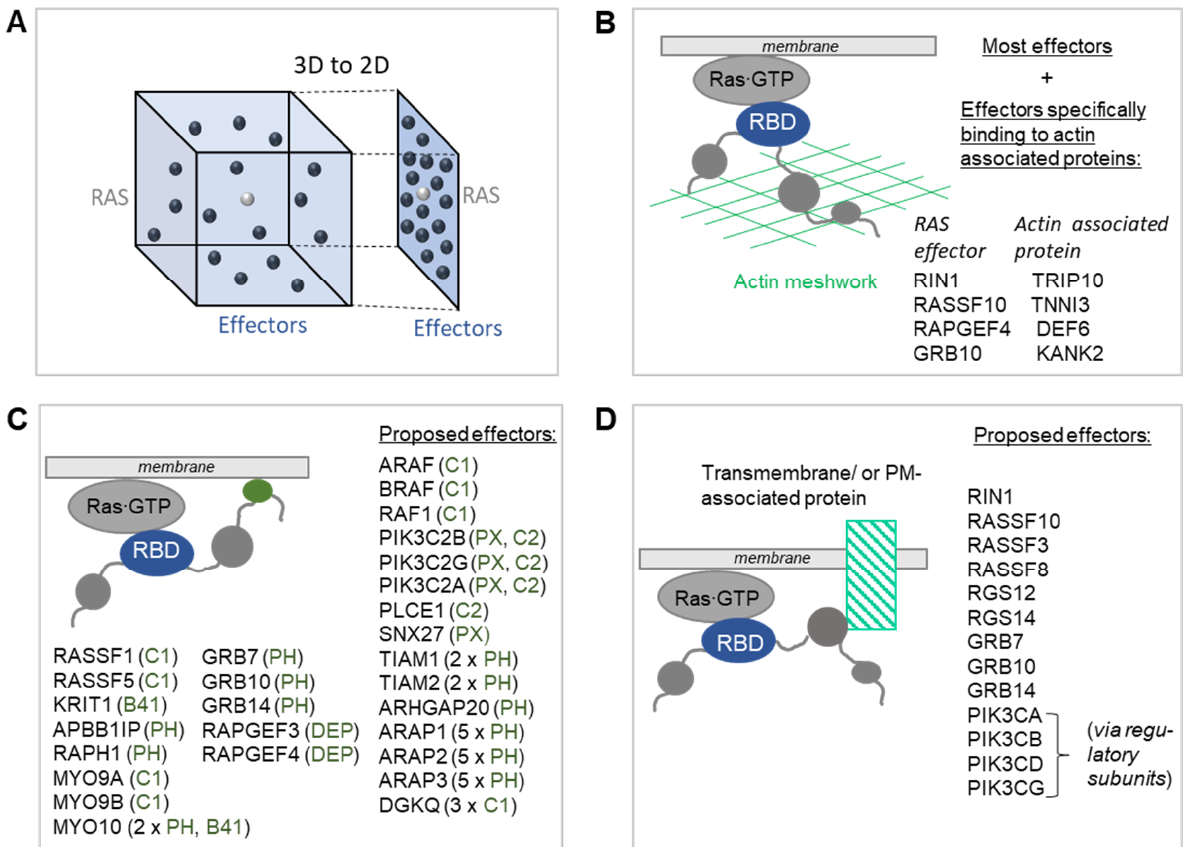
Figure 3. Mechanisms enhancing RAS effector recruitment. ( A ) The reduction of a three-dimensional space to the two- dimensions of a membrane can enhance the affinity between RAS and its effectors by >100 fold [29]. ( B ) Schematic representation of the recruitment of effectors to RAS∙GTP via their RBD and indication of the actin meshwork of the cell cortex. All effectors are predicted to increase their residence time in the PM once recruited via their RBD. Four effectors have been shown to bind to proteins that are located in the actin meshwork. ( C ) Representation of the recruitment of effectors to the membrane via their RBD and via membrane-binding domains. Twenty-six effectors contain domains that have the ability to bind to membranes (the names of the domains are indicated in green). ( D ) Recruitment of effectors via their RBD and via domains (or linear motifs) that bind to membrane-associated proteins.